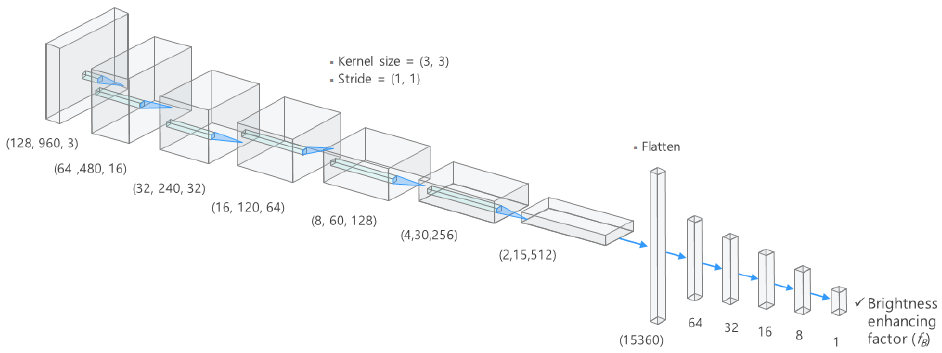
Figure 7. Schematic of the CNN-based image preprocessing model.